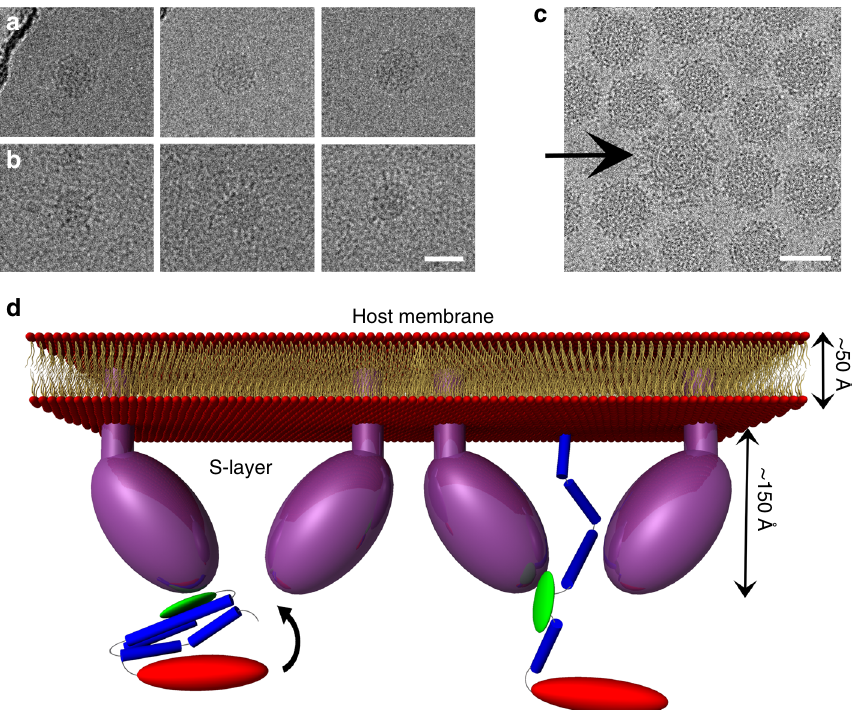
Fig. 6 HRPV VP5 extended conformation and proposed model. a HRPV-6 virions incubated at room temperature do not show extended spikes. b HRPV-6 virions incubated at 55 °C, showing VP5 in more extended conformation. c A cryo-EM image showing a particle with extended spikes (low salt). Scale bars correspond to 50 nm. d Proposed model for the rearrangement of HRPV spike from the pre-fusion to the membrane insertion step conformation. The N- and C-terminal domains of VP5 are coloured in blue and red, respectively, whereas the putative host recognition (N2) domain is coloured in green. VP5 would bind to the host via its N2 domain and opens up an elongated structure of